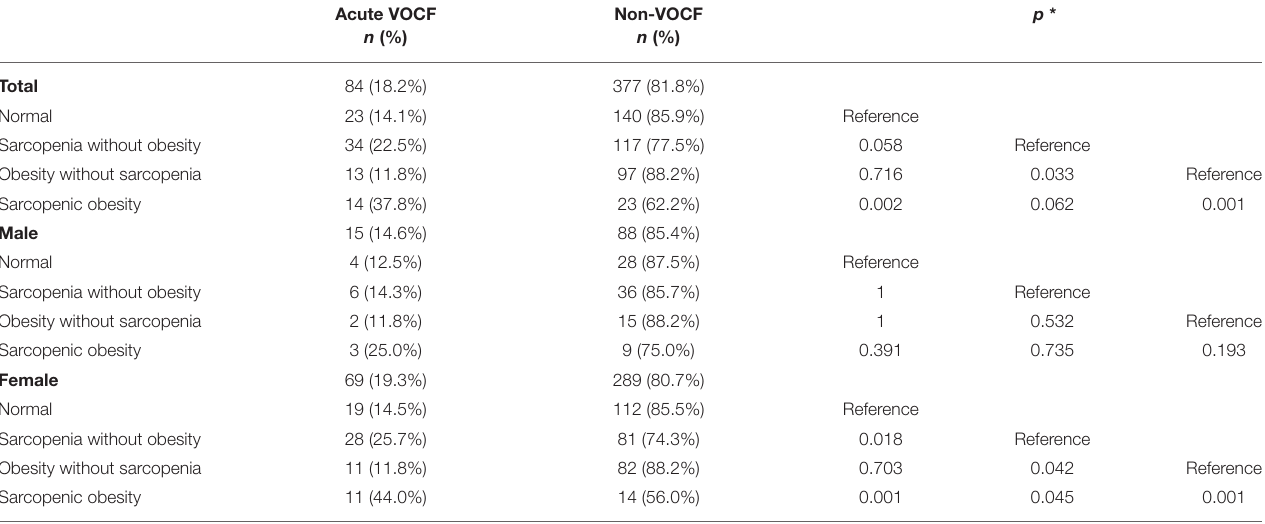
TABLE 4 | Post hoc analysis of the four groups by VOCF.